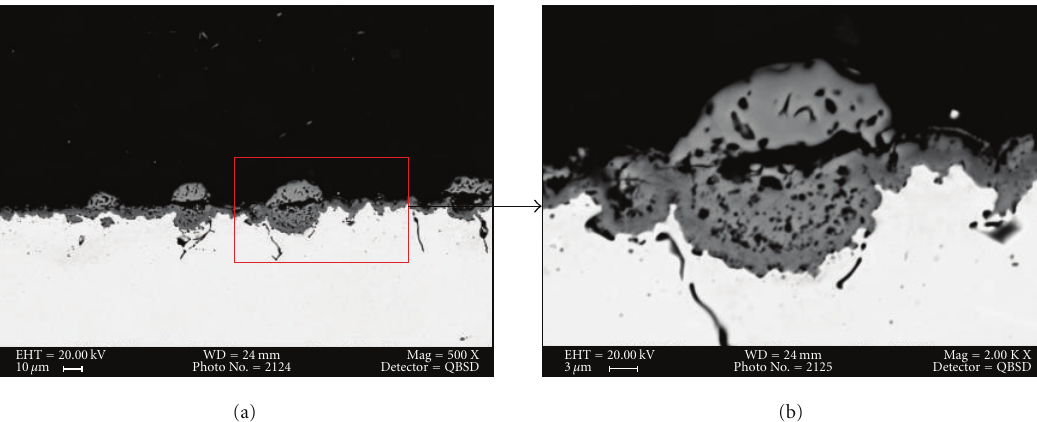
Figure 9: The SEM micrograph of the cross-section of AISI 316 corroded at T = 1000 ◦ C in synthetic air at di ff erent magnifications: (a) 500x and (b)